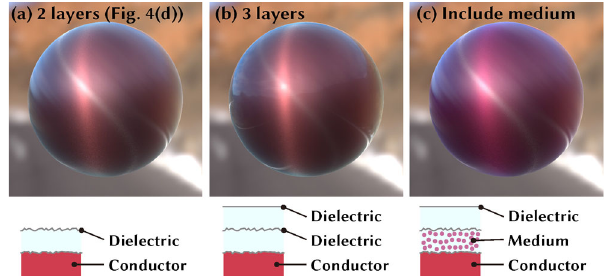
Fig. 8 Layered materials with more than two layers and with participating media are rendered using our method. The layer configurations are illustrated in the bottom. In material (b), the material shown in (a) is coated by a smooth dielectric layer ( η = 1 . 2). In material (c), a forward scattering layer ( g = 0 . 9 ,k s = (0 . 01 , 1 . 0 , 0 . 01) ,k a = (0 . 01 , 1 . 0 , 0 . 01)) is inserted in the middle of two layers of the material